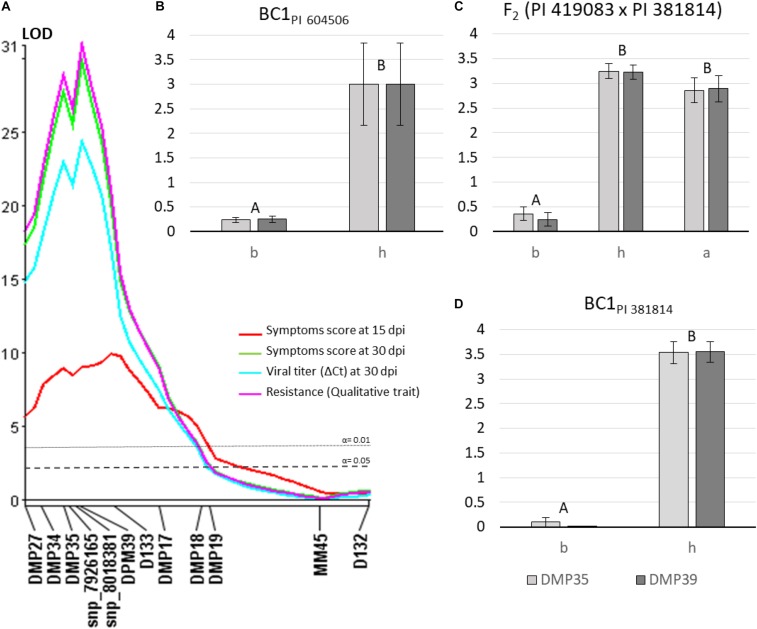
(A) Molecular markers linked to quantitative trait loci (QTLs) for the four traits [symptoms at 15 and 30 days after mechanical inoculation (dpi), virus titer at 30 dpi and the qualitative resistance trait] associated with ToLCNDV resistance. QTL location was obtained by composite interval mapping (CIM) method using F2 (PI 419083 × PI 604506). (B–D) Mean of symptom score at 30 dpi in BCPI 604506, F2 (PI 419083 × PI 381814) and BCPI 381814 populations, respectively, according to each genotypic class DMP35 (light gray bars) and DMP39 (dark gray bars) markers (chromosome 8). PI 604506 or PI 381814 homozygous genotype is represented as “b,” heterozygous as “h” and PI 419083 homozygous plants as “a.” Bars with same capitals letters are not significantly different at p ≤ 0.01.